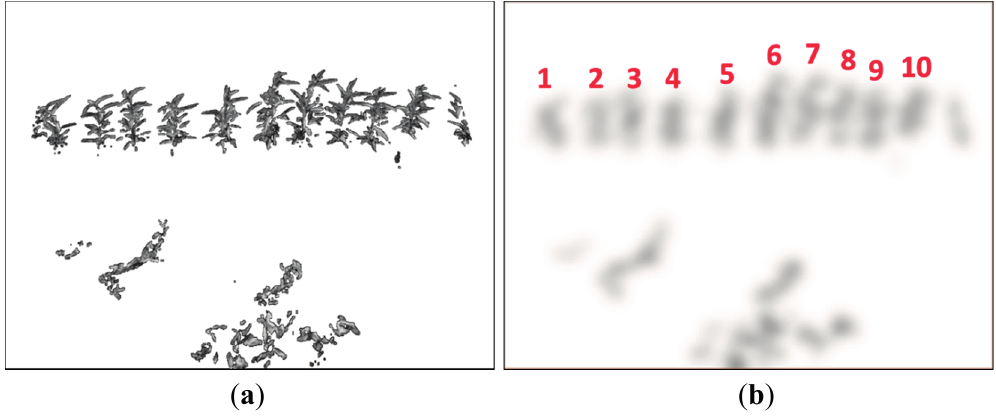
Figure 5. A green-segmented image ( a ) and its Gaussian smoothed image ( b ) where plants are